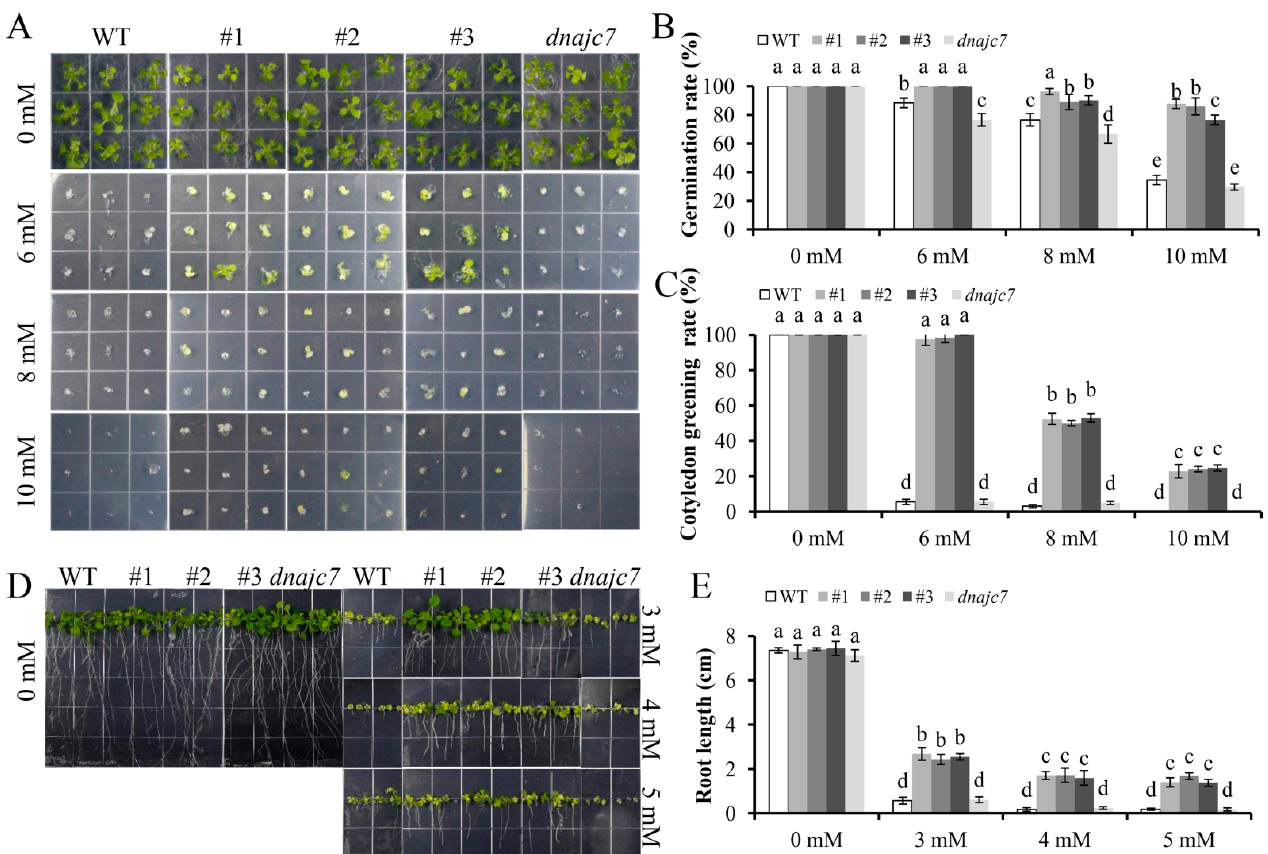
Figure 6. The effect of GmDNAJC7 ectopic expression on Arabidopsis tolerance to NaHCO 3 treatment. ( A ) Seed germination assay of different Arabidopsis lines on 1/2 Murashige and Skoog (MS) agar plates and 1/2 MS supplied with various concentrations of NaHCO 3 . Photographs were taken 10 days after treatment. WT: wild type; #1, #2, #3: Arabidopsis lines overexpressing GmDNAJC7 ; dnajc7 : Arabidopsis mutant. ( B , C ) Seed germination rates after five days and cotyledon greening rates after 10 days for different Arabidopsis lines as shown in A. ( D ) Phenotypes of Arabidopsis lines subjected to 0, 3, 4, and 5 mM NaHCO 3 treatment for 10 days, respectively. ( E ) Root lengths of Arabidopsis lines as shown in ( D ). Root lengths were analyzed using ImageJ software. Bars represent the mean values ± standard deviations of three independent experiments and each repeat contained at least four independent plants per line for each treatment ( n ≥ 12). Bars with the same letters in lowercase above bars indicate no significant differences at the 0.05 level according to the Duncan’s multiple range tests.